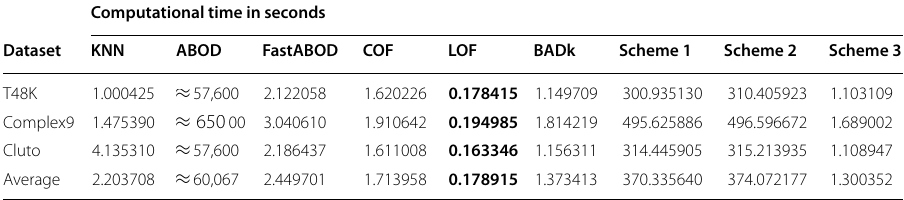
Bold values indicate are